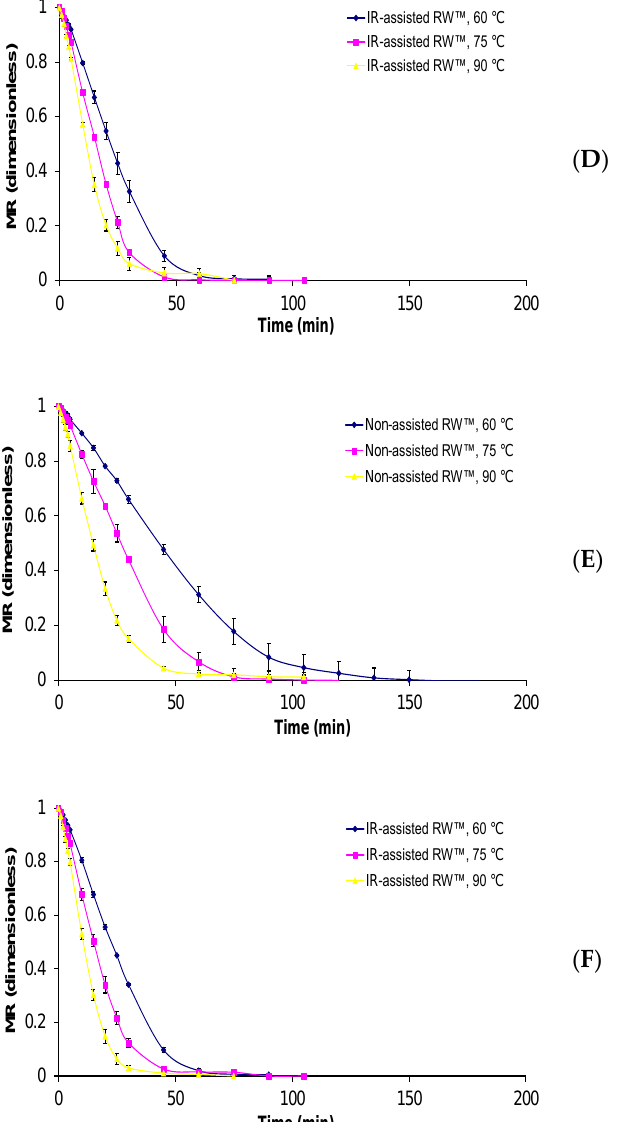
Figure 2. Physalis purée drying curves subjected to different RW ™ drying conditions, where ( A ) non-assisted RW ™ and ( B ) IR-assisted RW ™ with Mylar ™ thickness of 0.19 mm; ( C ) non-assisted RW ™ and ( D ) IR-assisted RW ™ with Mylar ™ thickness of 0.25 mm; ( E ) non-assisted RW ™ and ( F ) IR-assisted RW ™ with Mylar ™ thickness of 0.29 mm. Moisture ratio (MR).